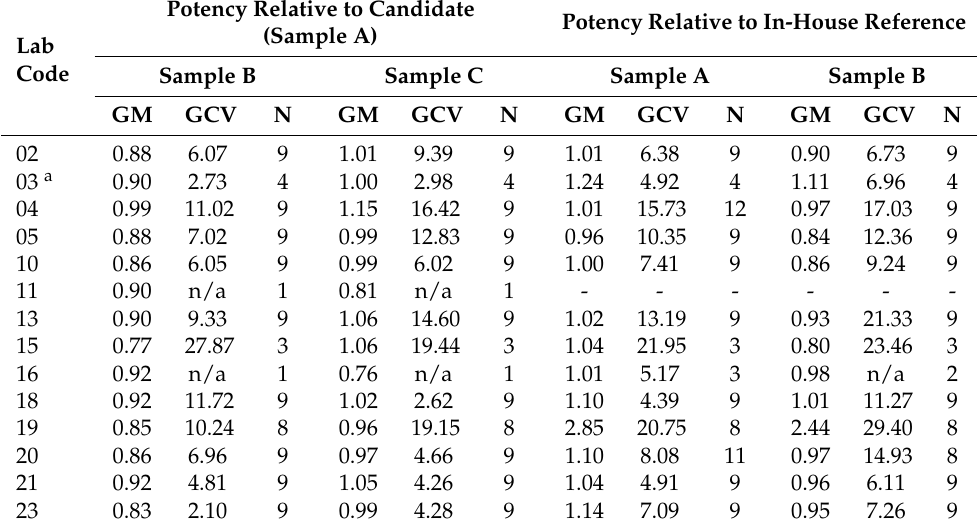
Table 8. Individual laboratory geometric mean relative potency estimates for binding assays.